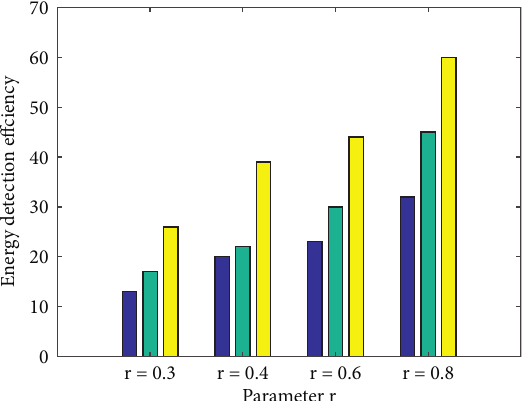
Figure 8: Energy consumption monitoring results under different